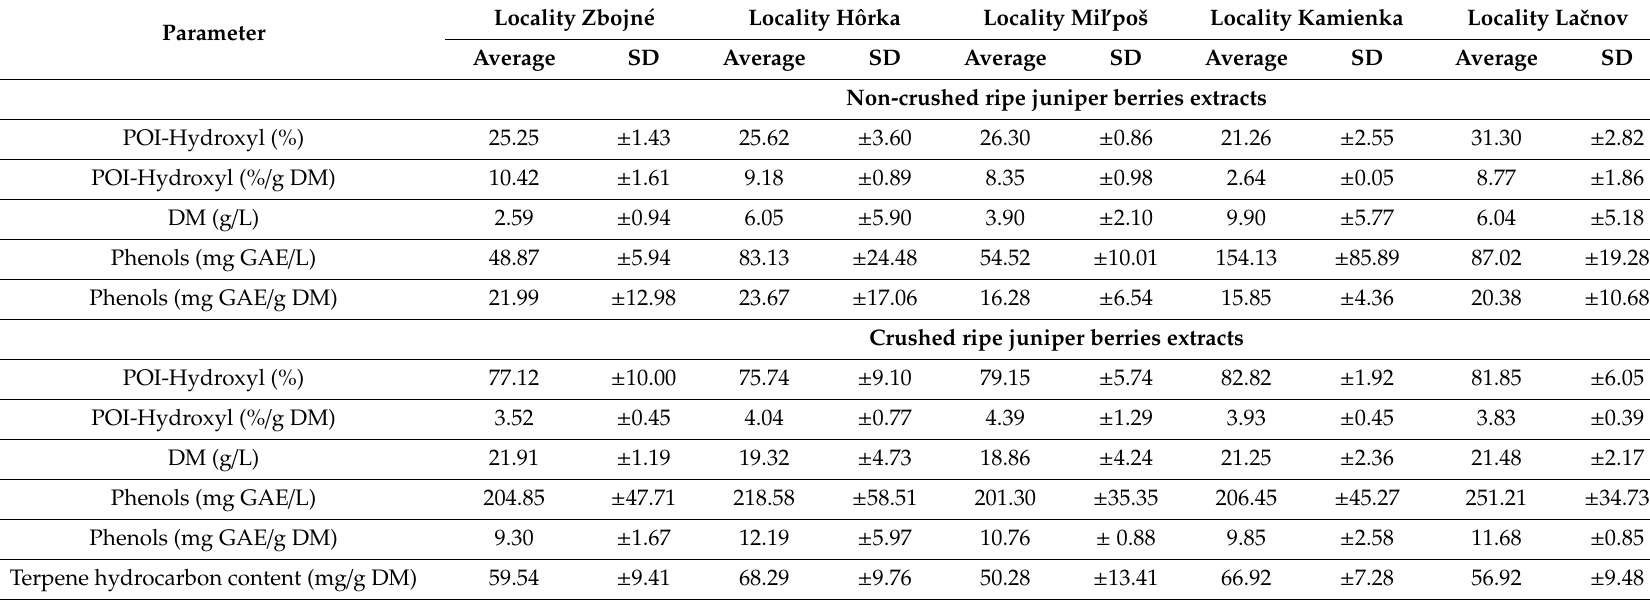
Table 2. Average values (3 years, 2012–2014) of antioxidant activity against hydroxyl radicals, dry matter, total phenols and contents of essential oil components in 70% ethanol extracts of juniper